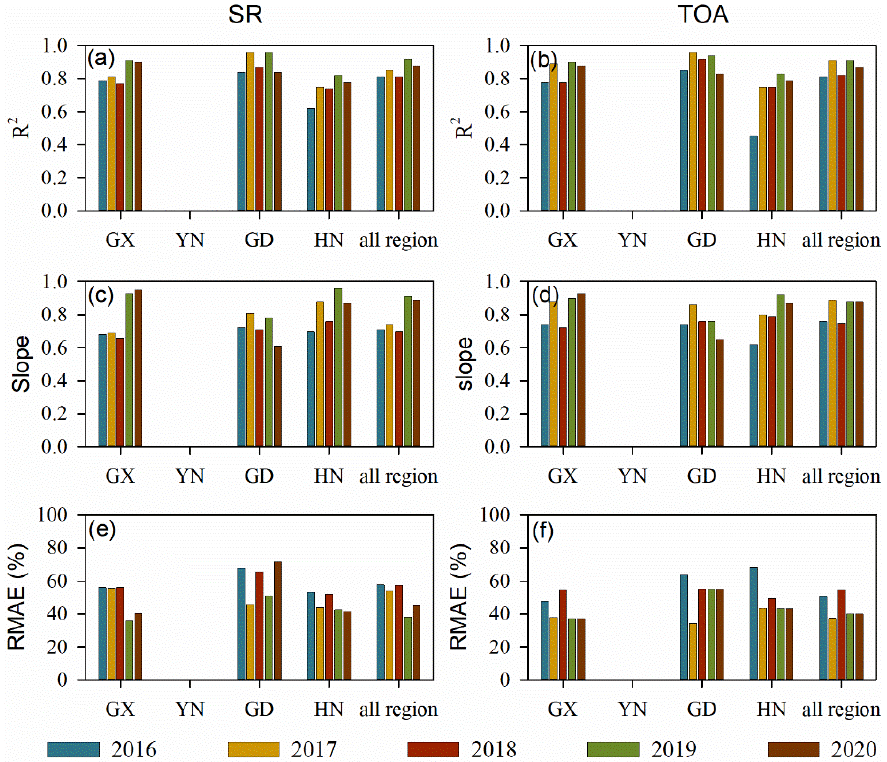
Figure 10. Correlations between the estimated and agricultural statistical planted areas of sugarcane (R 2 , slope, and RMAE) at the county level in China for each year from 2016 to